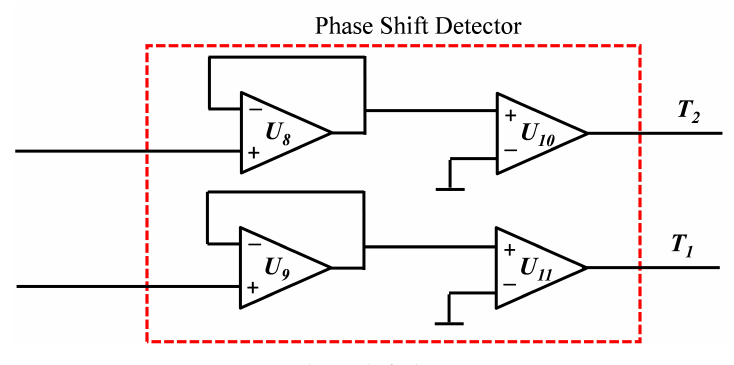
Figure 11. Phase shift detector